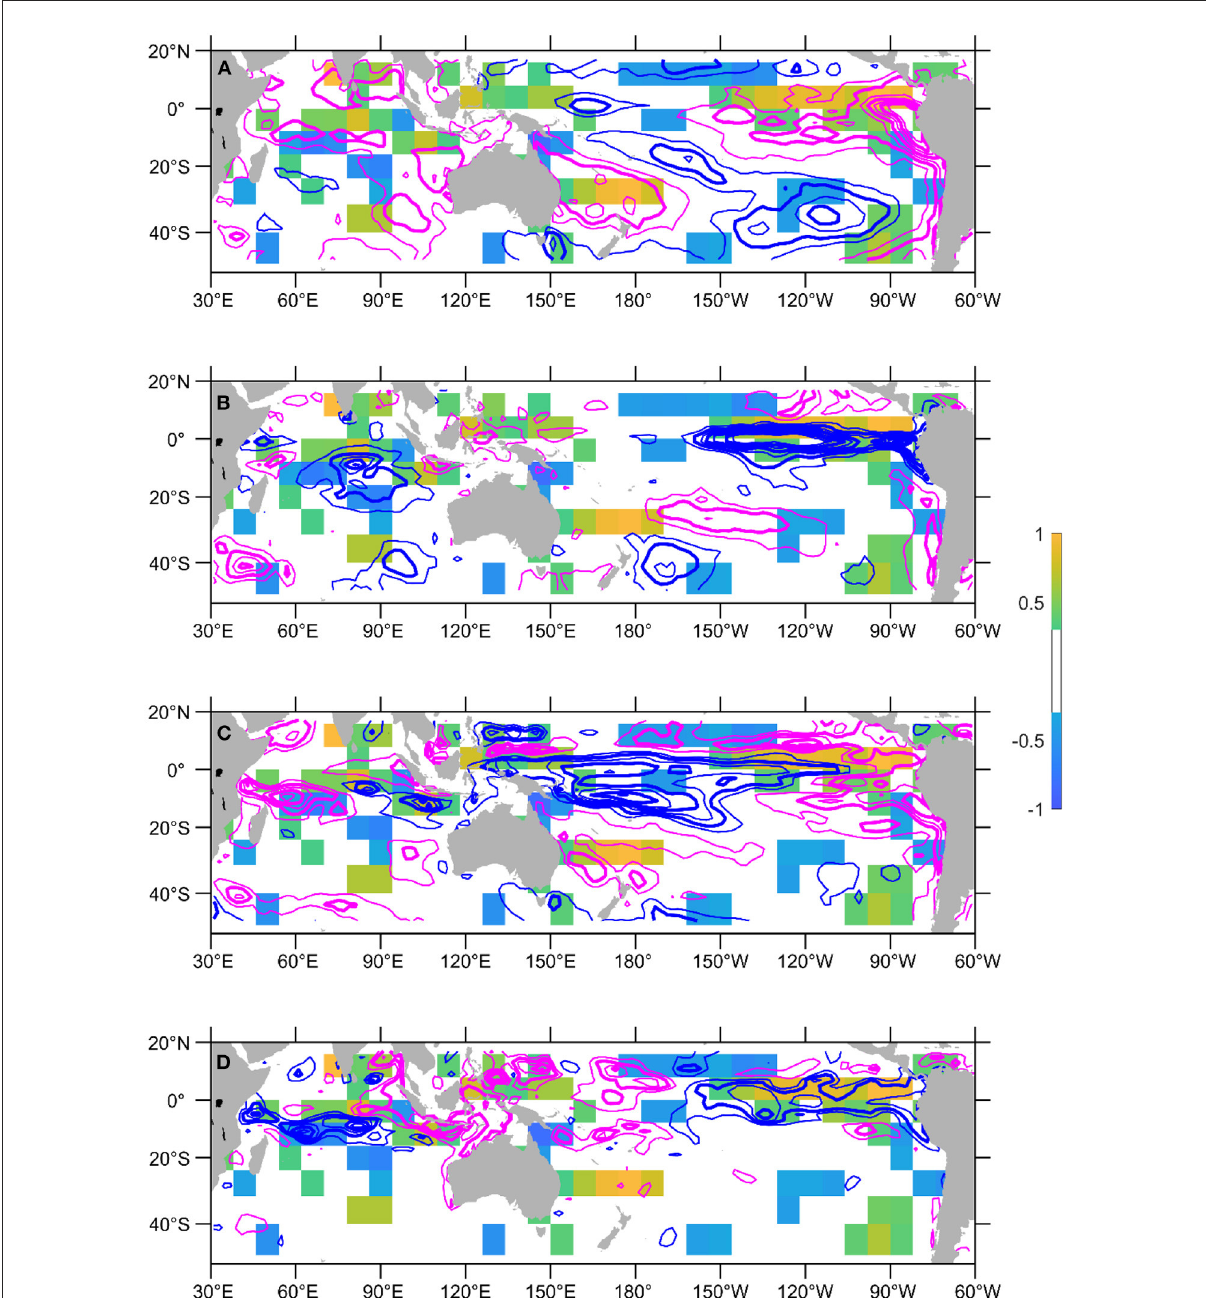
FIGURE8 Activation map of using May-June-July SST and heat content anomalies to forecast the September 1998 EIOD peak (only showing absolute values > 0.3). The activation map is overlaid with (A) SST anomalies in June 1998, (B) SST anomaly differences between July and May 1998, (C) heat content anomalies in June 1998, and (D) heat content anomaly differences between July and May 1998. Negative anomalies are denoted with blue contours and positive anomalies with magenta. Anomalies are plotted every 0.5 ◦ C, and the integer values are in bold contour. Zero contour lines are not